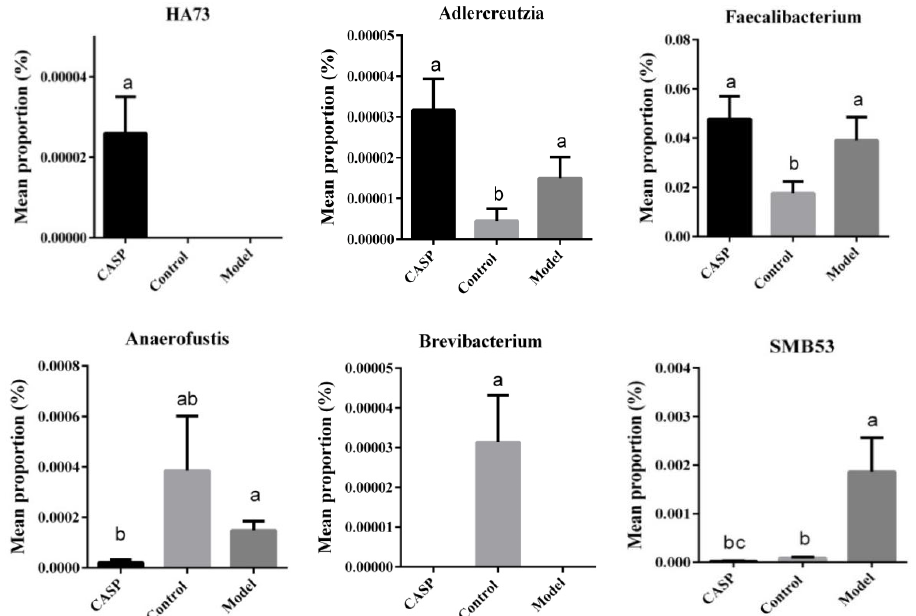
Figure 10. STAMP difference analysis of cecum content floras in each group. Note: The same letter, and the different letter indicate that the inter-group differences difference is non-significant or significant, respectively.